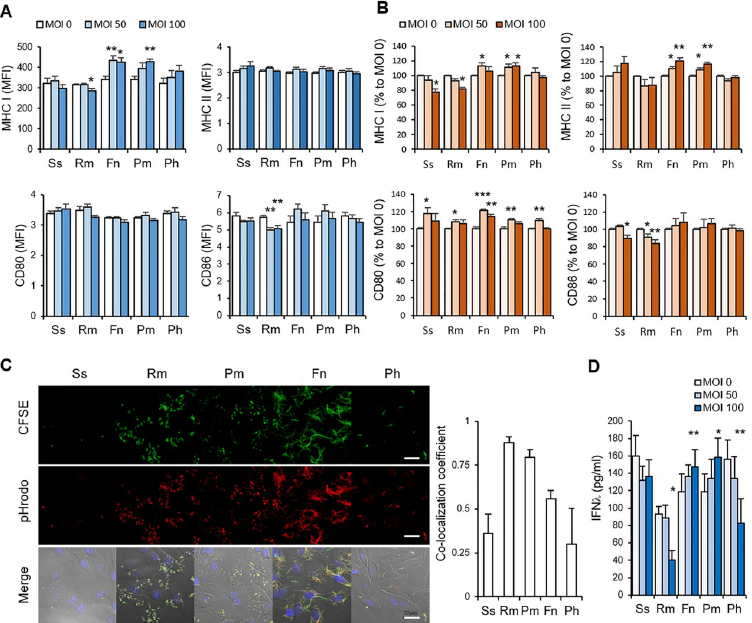
Fig 2. Deregulation of SGECs by P . melaninogenica in vitro . (A and B) HSG cells were cocultured with S . salivarius (Ss), R . mucilaginosa (Rm), F . nucleatum (Fn), P . melaninogenica (Pm), and P . histicola (Ph) at MOIs of 0, 50, and 100 for 3 days in the absence (A) or presence (B) of IFN γ . The expression levels of MHC I, MHC II, CD80, and CD86 were analyzed by flow cytometry. The data are presented as the means ± SEMs of 3 experiments performed in duplicate. The data obtained in the presence of IFN γ were normalized to noninfected control cells (MOI 0) to normalize the variable effects of IFN γ from experiment to experiment. � , P < 0.05; �� P < 0.01 versus MOI 0 by t-test. (C) HSG cells grown on coverslips were infected with each bacterial species, which had been double-stained with CFSE and pHrodo Red, at an MOI of 100 for 6 hours. The cells were examined by confocal microscopy. The scale bars indicate 20 μ m. The colocalization coefficient of pHrodo over CFSE is shown in the graph in the right panel. (D) HSG cells were cocultured with each oral bacterial species at MOIs of 0, 50, and 100 for 3 days in the absence of IFN γ . The concentrations of IFN- λ 1/3 in the culture supernatant were measured by ELISA. The data are presented as the means ± SEMs of 3 experiments performed in duplicate. � , P < 0.05; �� P < 0.01 versus MOI 0 by t-test.